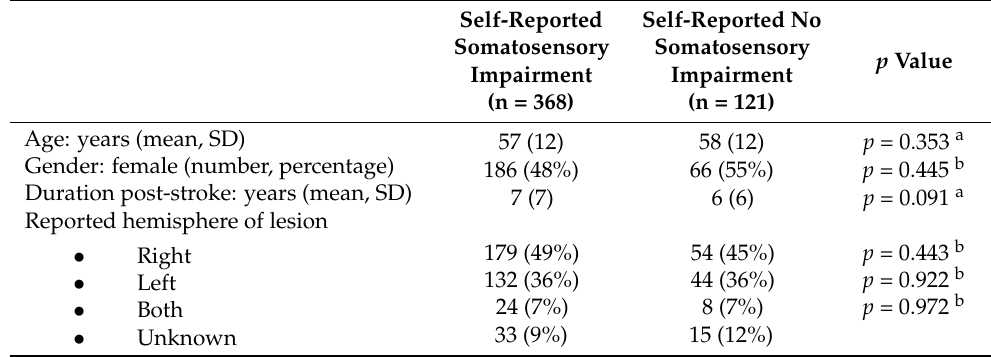
Table 2. Age, gender, stroke chronicity and reported hemisphere of lesion reported within samples with and without perceived presence of somatosensory impairment.